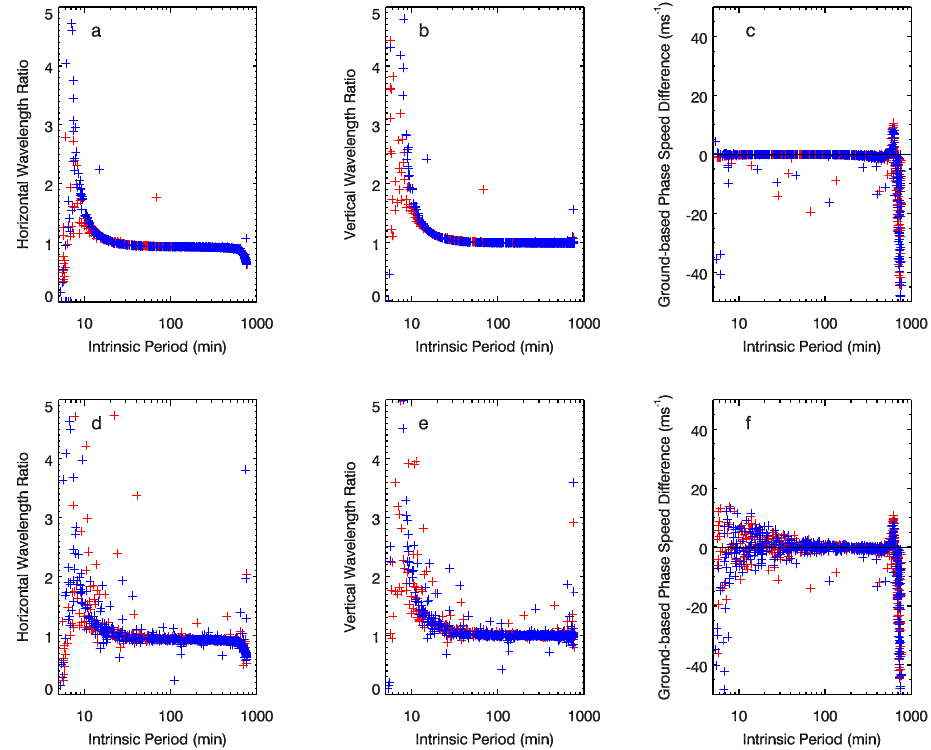
Fig. 7. As in Fig. 6, but for (a) and (d) the ratio of simulated to input horizontal wavelength ( (λ h ) sim /(λ h ) in ). (b) and (e) for vertical wavelength ratio ( (λ z ) sim /(λ z ) in ). (c) and (f) difference between simulated and input ground-based horizontal phase speed ( cg sim − cg in ). Table 4. Mean values of simulated parameters and their standard deviations. Here, 1 ˆ c , 1θ , 1(ρ o u 0 w 0 ) and 1c g are the differences between the respective simulated and input values. The other quantities are the ratios of the simulated to input values. The ˆ τ ratio denotes the ratio of the retrieved intrinsic wave period to the input value and the τ g ratio is the ratio of the retrieved to input ground-based period. Figures in brackets are median values. The statistics are provided for the full GW frequency range ( N > ˆ ω > f ), unless otherwise stated, and both up and down going waves are included in the